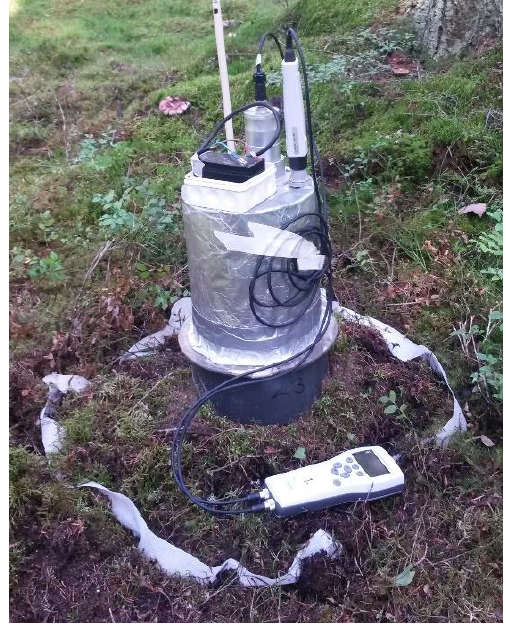
Figure 2. Soil surface respiration chamber darkened with aluminum foil and containing the CARBOCAP® GMP343 CO 2 probe and a data logger on the ground in front. The measurement point is one of the trenched measurement points. Photo: Maiju Kosunen.